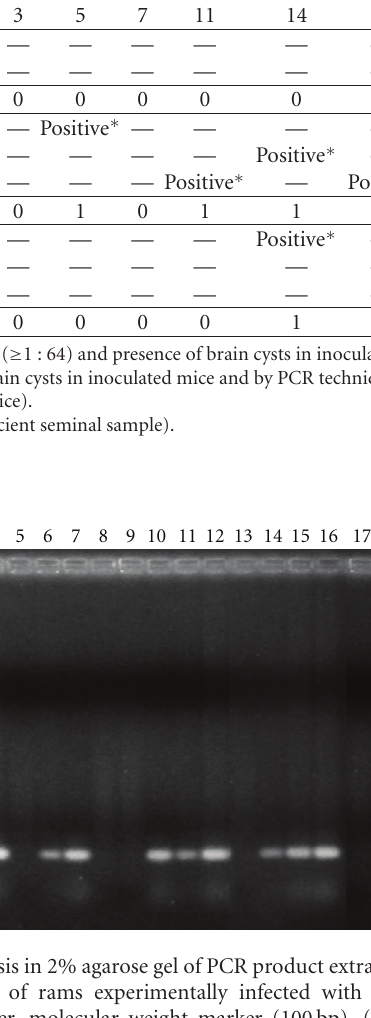
from tissue pool samples (testicles, epididymis, seminal vesicle, and prostrate) of the experimental ram (1) DNA Ladder, molecular weight marker (100 bp). (2) Ram 02 (GI). (3) Ram 09 (GI). (4) Ram 16 (GI). (5) Ram 07 (GII). (6) Ram 48 (GII). (7) Ram 52 (GII). (8) Ram 43 (control). (9) Ram 44 (control). (10) Positive control. (11) Negative